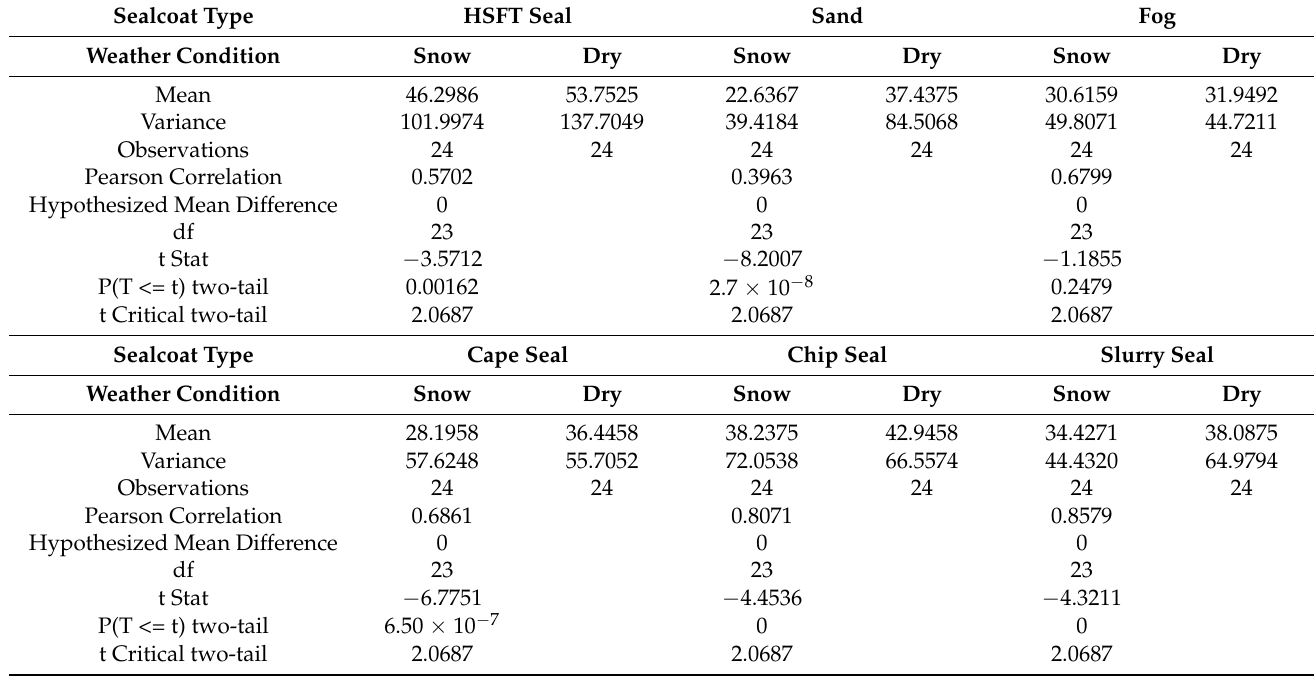
Table 1. t -Test: paired two sample for means.